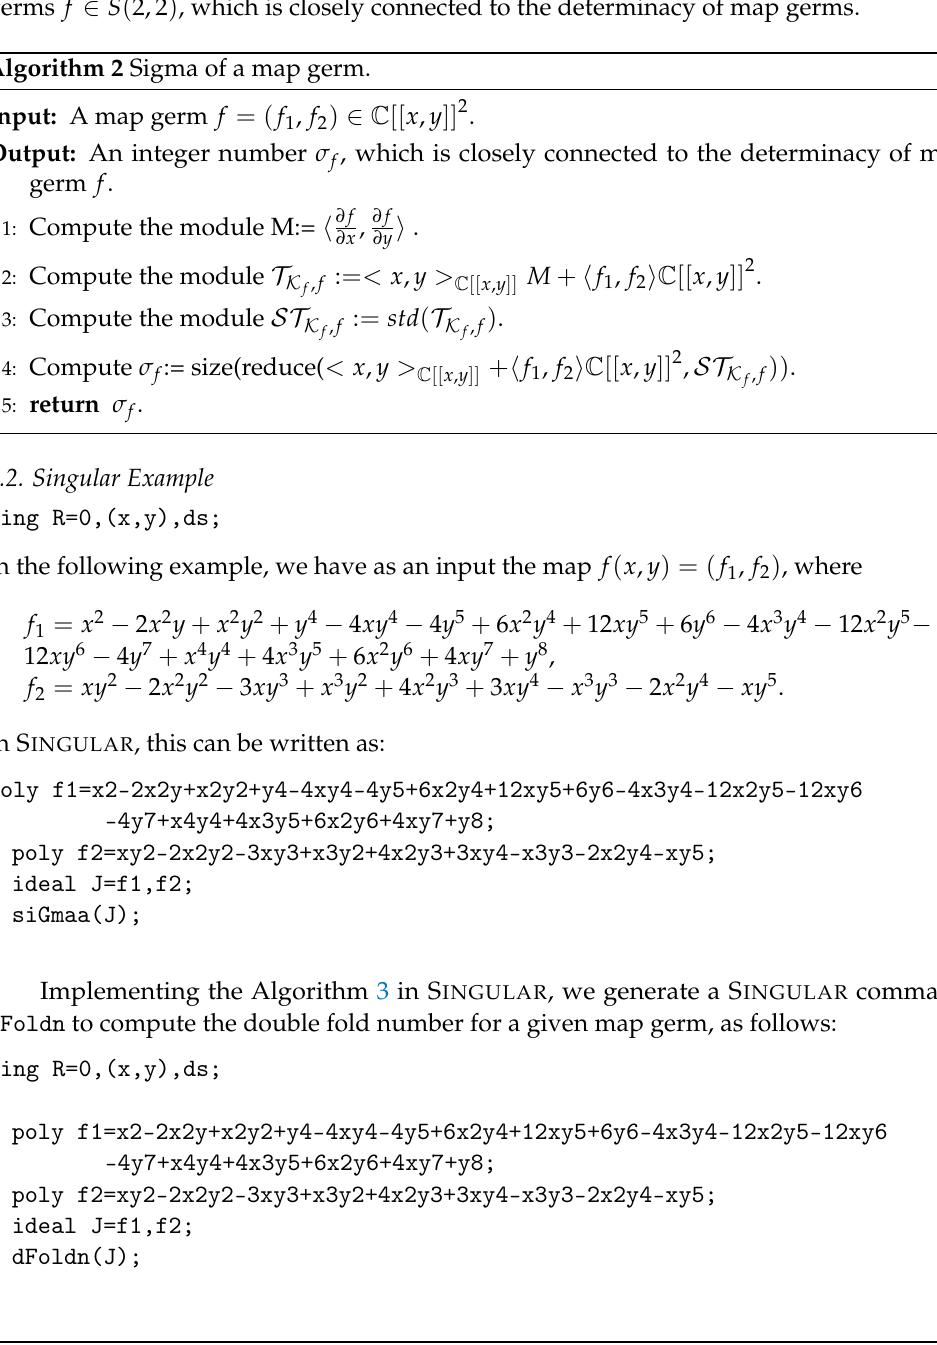
Algorithm 3 Double fold number of a map